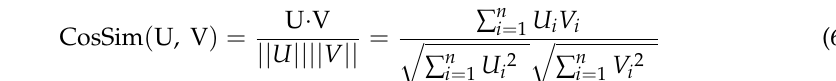
Figure 7. The basic architecture of VGG Net [73] (reproduced with permission); CONV: convolution layer and FC: fully connected network.